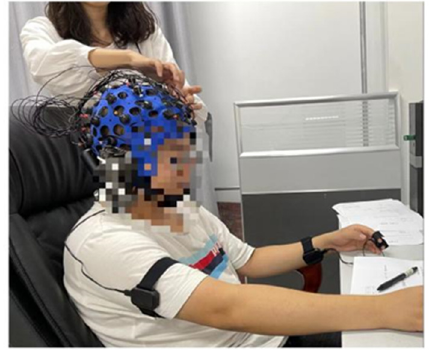
Figure 5. Testing machines.